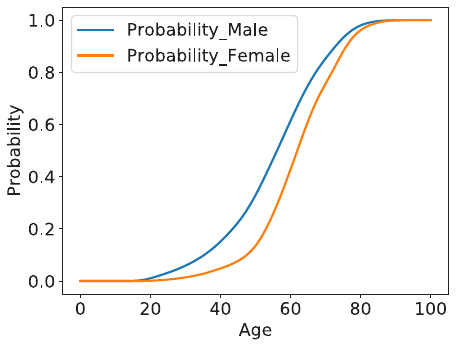
Figure 1. The cumulative distribution function used to define the AH status of an individual, based on data from